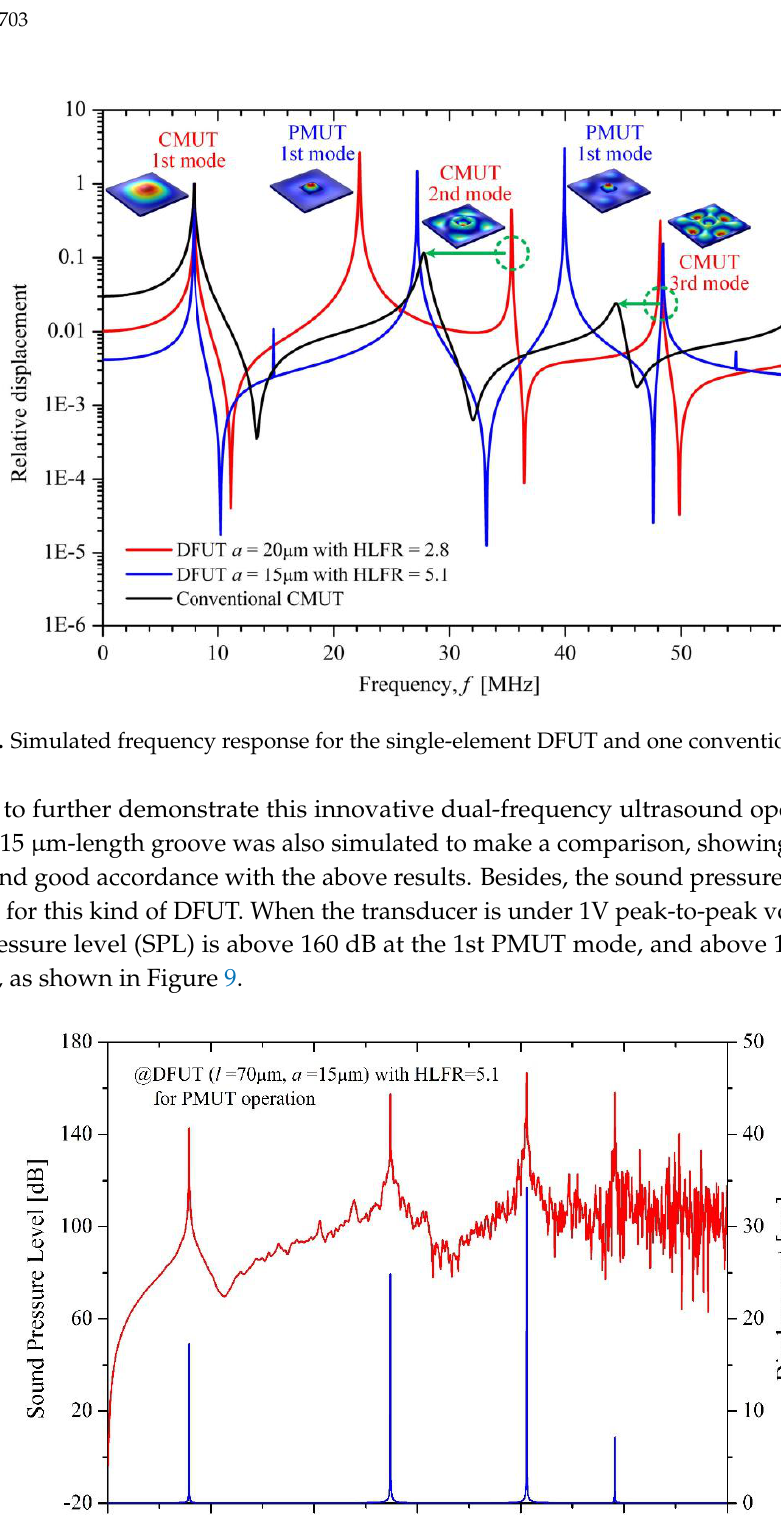
Figure 9. Ultrasound pressure generated near the top surface of the DFUT under 1V pp electrical excitation.